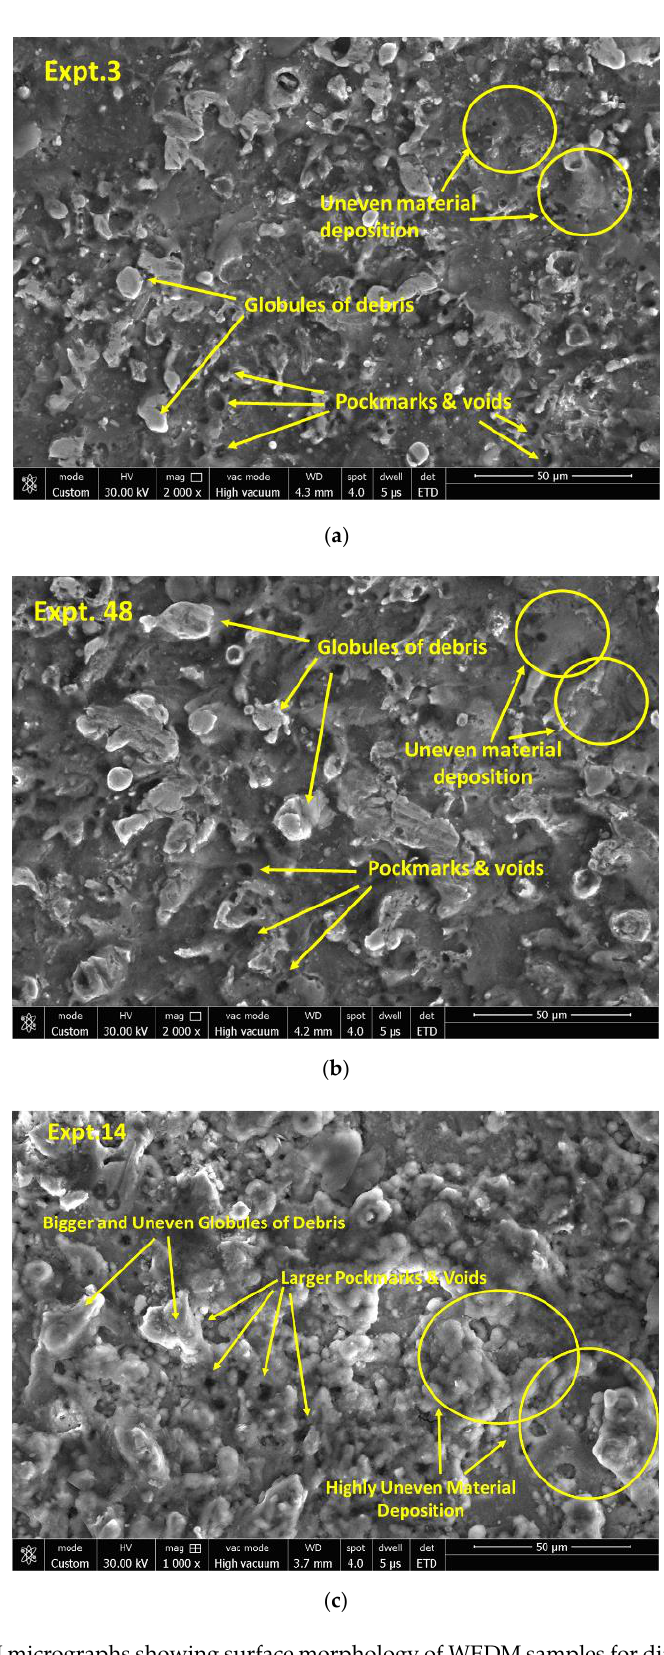
Figure 9. FESEM micrographs showing surface morphology of WEDM samples for different parametric settings. ( a ) Experiment 3: T ON = 100 µs, T OFF = 60 µs, SV = 40 V, I P = 120 Amp, and WT = 1.1 settings. ( a ) Experiment 3: T ON = 100 µ s, T OFF = 60 µ s, SV = 40 V, I P = 120 Amp, and WT = 1.1 kg. kg. ( b ) Experiment 48: T ON = 110 µs, T OFF = 50 µs, SV = 50 V, I P = 150 Amp, and WT = 1.1 kg. ( c ) ( b ) Experiment 48: T ON = 110 µ s, T OFF = 50 µ s, SV = 50 V, I P = 150 Amp, and WT = 1.1 kg. ( c ) Experiment Experiment 14: T ON = 120 µs, T OFF = 40 µs, SV = 60 V, I P = 180 Amp, WT = 1.1 kg. 14: T ON = 120 µ s, T OFF = 40 µ s, SV = 60 V, I P = 180 Amp, WT = 1.1